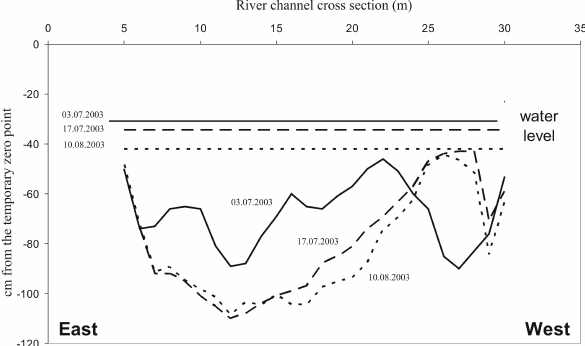
Fig. 6. Depth measurements across the channel at the head of En- myvaam River during summer 2003, compared to the river water levels at the respective